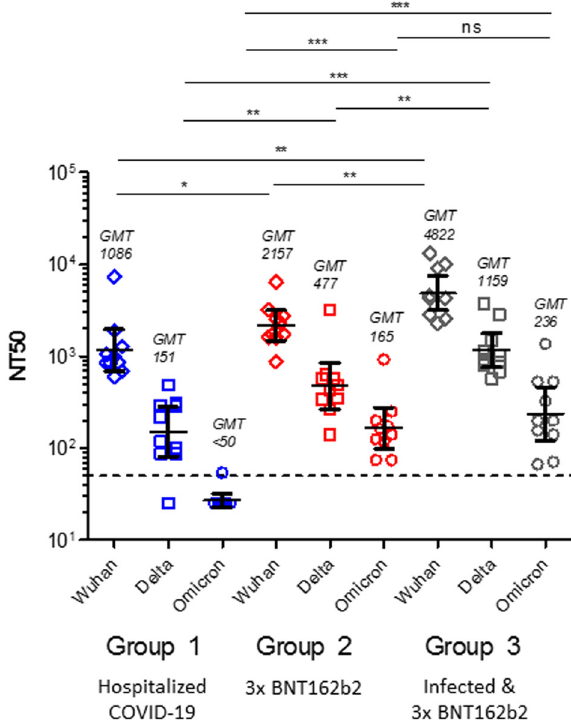
Fig. 1 Neutralising antibody titre (NT50) against lineage B (Wuhan-Hu-1), Delta and Omicron variants. GMT (Geometric mean titer) with 95% CI, P values Mann – Whitney test: ***(< 0.001), **(< 0.01) for the three groups of samples analysed. The dotted line represents the assay cut-off (NT 50 = 50). Additional statistical analysis can be found in Suppl. Table